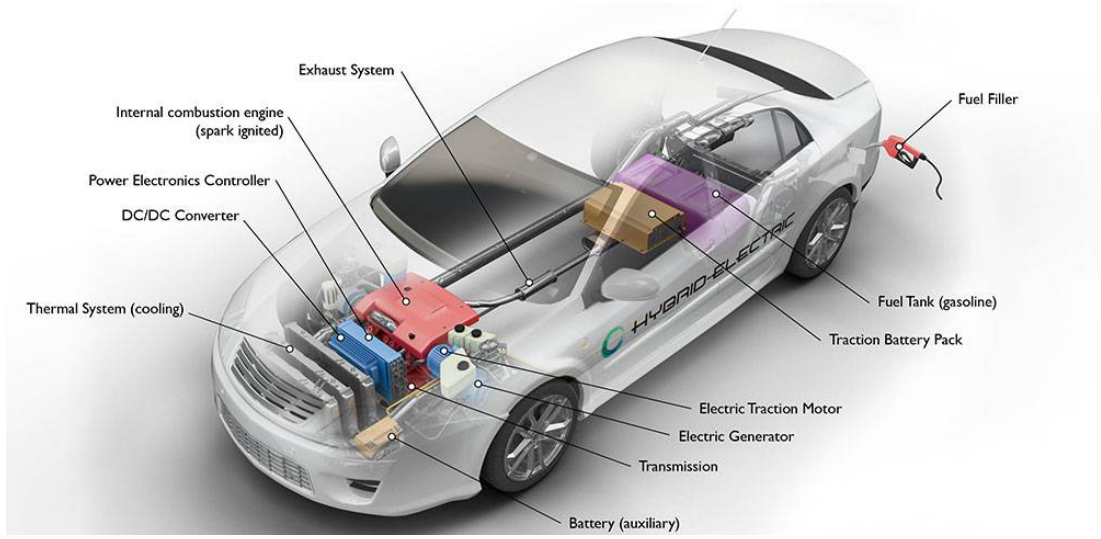
Figure 18. Schematic of a hybrid electric vehicle (HEV) and its main components [91].